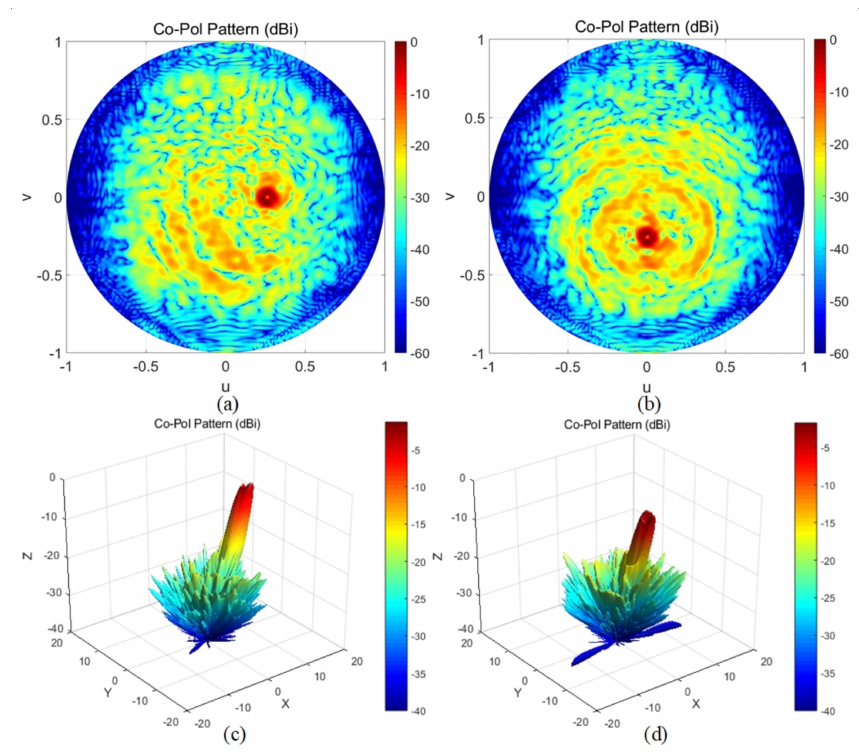
Figure 9. Measured far-field patterns with di ff erent azimuth directions in di ff erent coordinate systems: